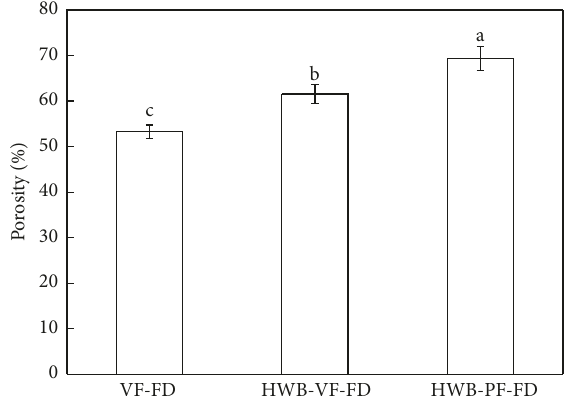
Figure 10: Porosity of freeze-dried samples in 3 freeze-drying methods. VF-FD: apple samples without hot-water pretreatment were performed with vacuum freezing treatment and freeze-drying process; HWB-VF-FD: apple samples with hot-water pretreatment were performed with vacuum freezing treatment and freeze-drying process; HWB-PF-FD: apple samples with hot-water pretreatment were performed with plate freezing treatment and freeze-drying process. Note . Different letters on the same bar indicate significant differences at 𝑝 = 0.05 by Tukey’s HSD